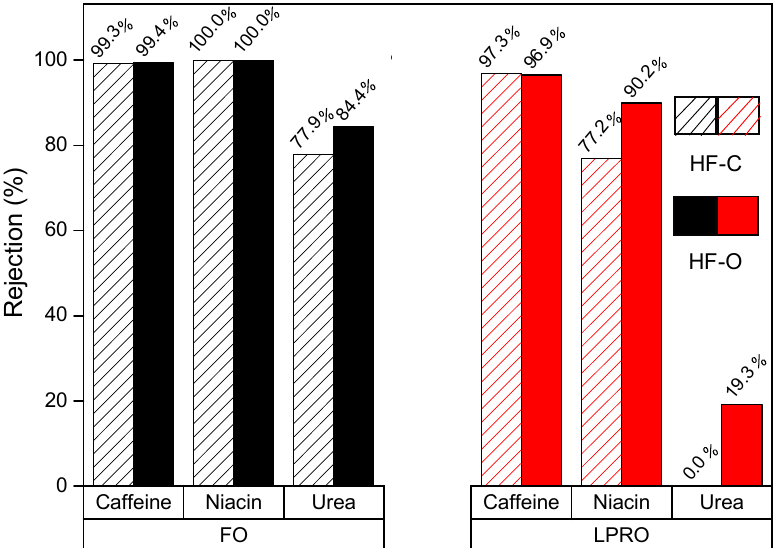
Figure 15. Rejection of ca ff eine, niacin, and urea for HF–C and HF–O modules in LPRO and FO. Each compound was tested individually with a feed concentration of 200 mg · L − 1 . Feed flow rates were modified for FO (130–140 L · h − 1 ) and LPRO (30–60 L · h − 1 ) to obtain 23 ± 4% recovery for all the tests. LPRO tests were carried out with a TMP of 2 bar and FO tests were carried out with 0.5 M NaCl as a DS with a flow rate of 16 Lh − 1 for all the